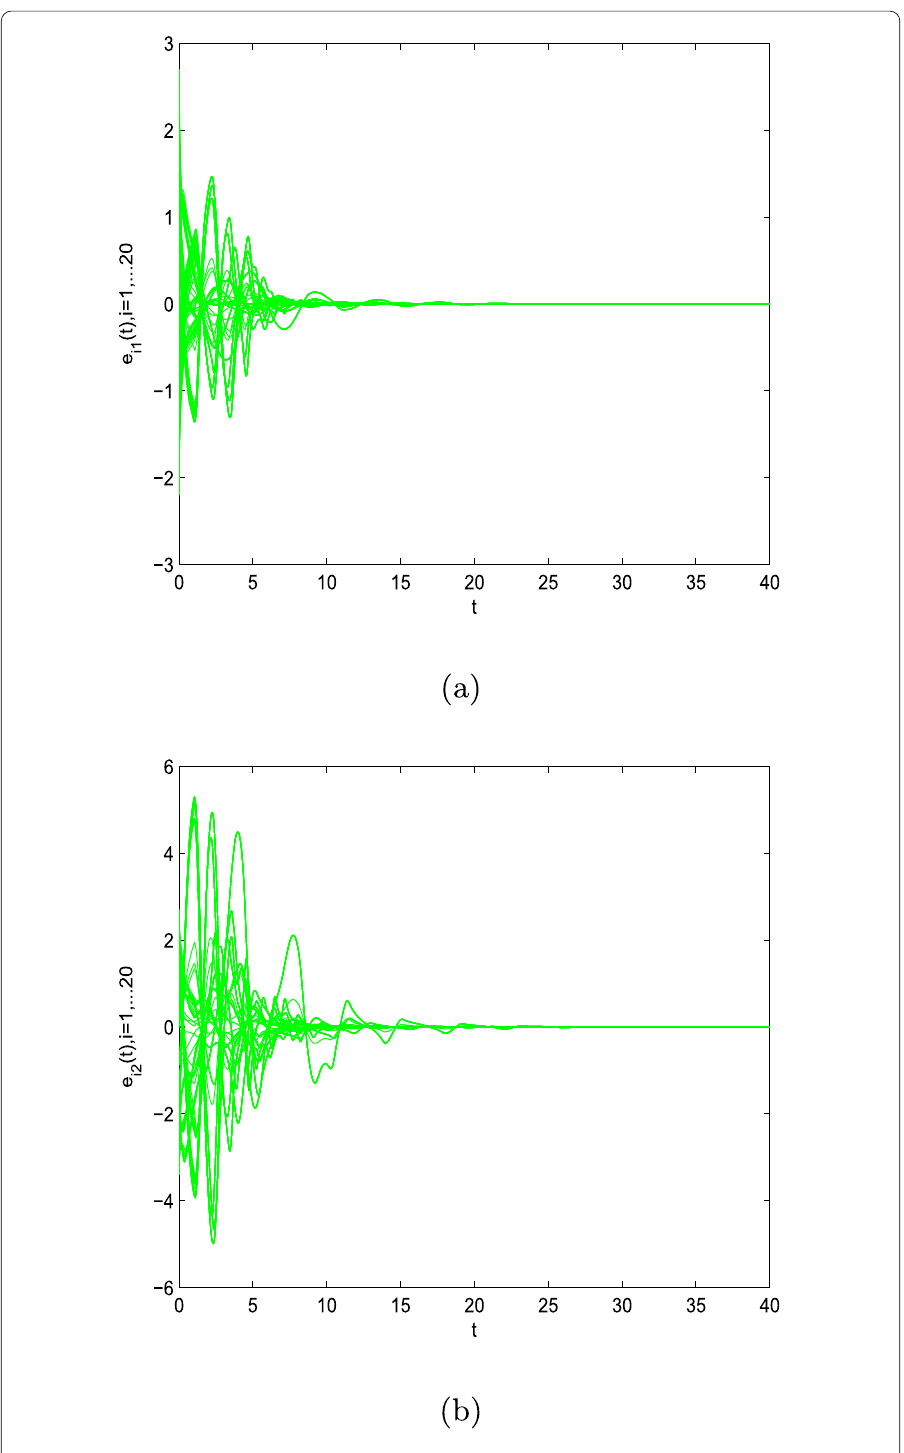
Figure 3 The evolution of e i 1 ( t ), e i 2 ( t ) in system (30) under pinning